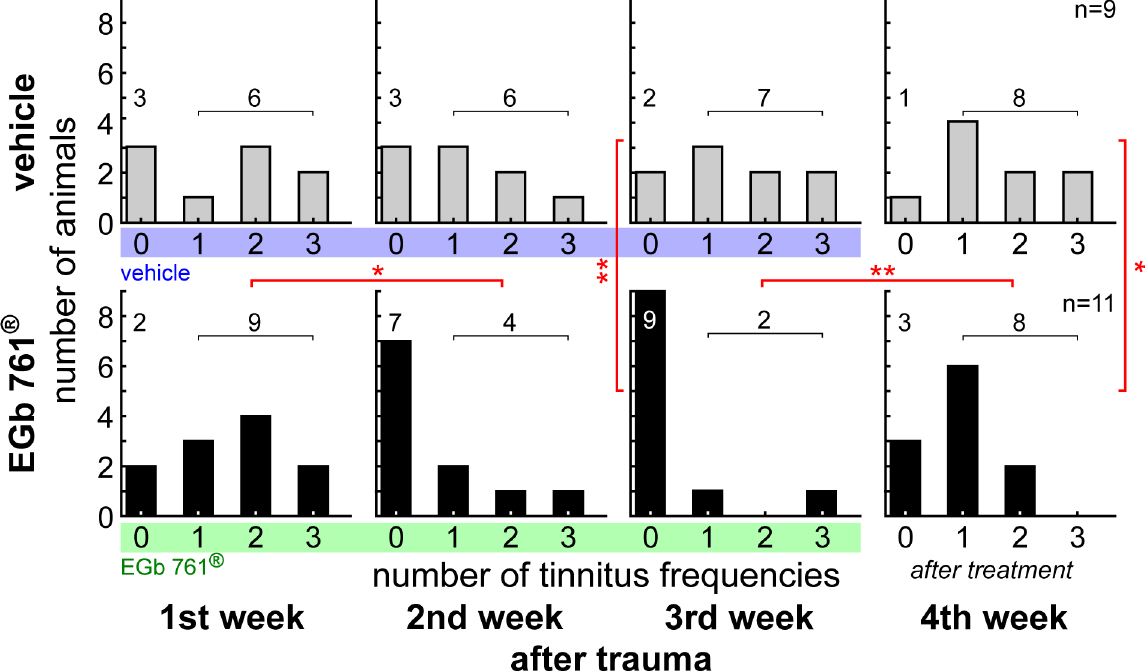
Fig 3. EGb 761 alleviates behavioral signs of noise-induced tinnitus perception. Given are the distributions of the number of perceived tinnitus frequencies as a function of the week relative to treatment onset. Numbers on the abscissae indicate how many frequencies were tested positive for a tinnitus percept in a given animal (cf. Methods), with zero referring to animals with no tinnitus, and one to three referring to the number of affected frequencies that may be taken as a measure for tinnitus severeness. The ordinates give numbers of animals affected accordingly. Note that the distributions of the two groups were tested at each time point against each other as well as within one group between different time points. Asterisks indicate the significant changes over time or the differences between the groups tested by Kolmogorov-Smirnov tests corrected for multiple comparisons, * p < 0.05, ** p < 0.01.